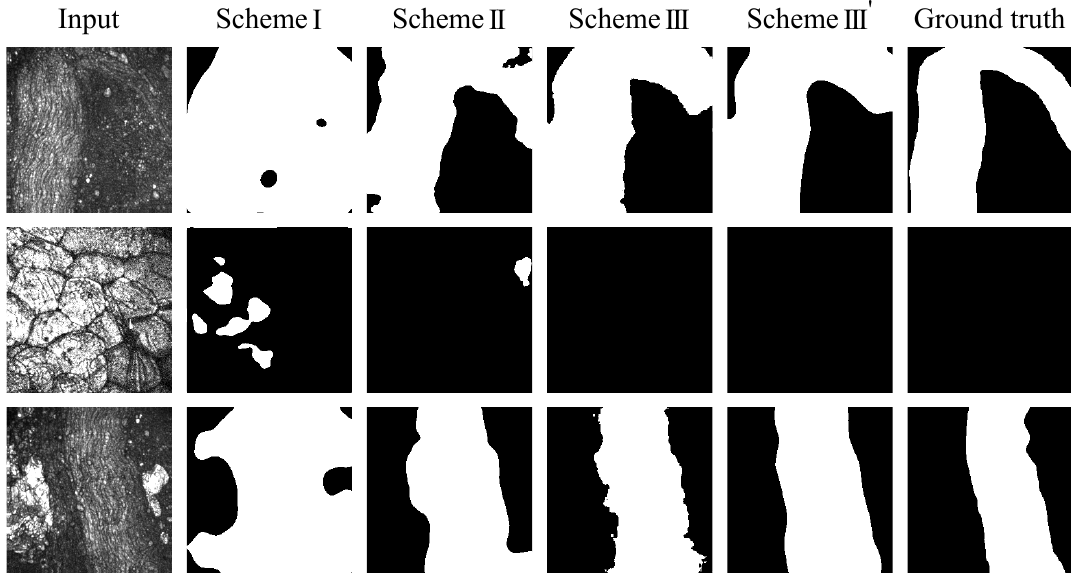
Figure 5. Results of nerve segmentation with four learning schemes.